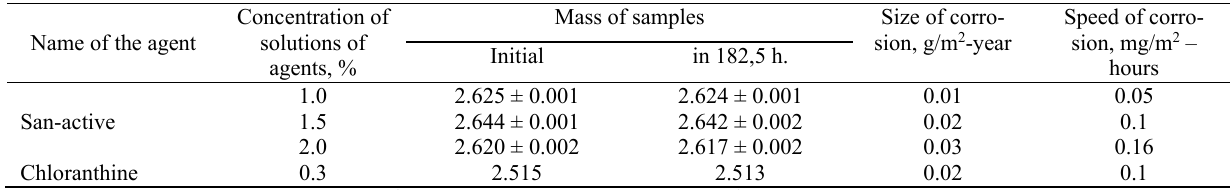
Corrosive action of solutions of detergent “San-active” on stainless steel, M ± m, n = 9 Name of the agent